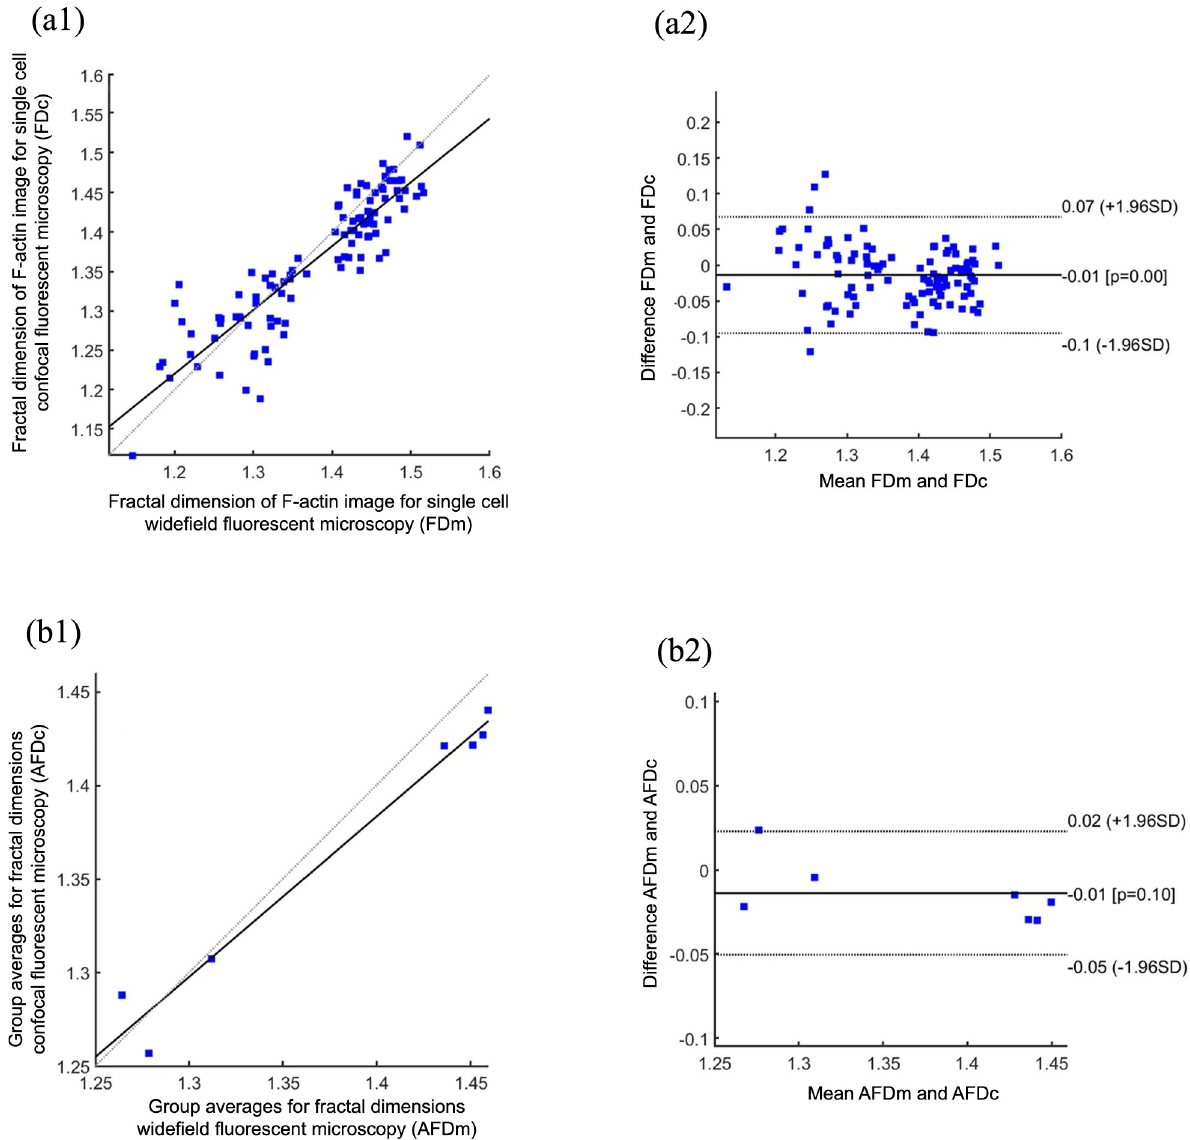
Fig 6. Correlation plot and Bland-Altman plot for FD values calculated for F-actin images captured using confocal and widefield microscopy techniques. (a1) and (a2) for FDs of all values which had been used in analysis (n = 105). (b1) and (b2) for average values of groups (n = 7) which were treated with different concentrations of Lat B (n = 15 cells in each experimental